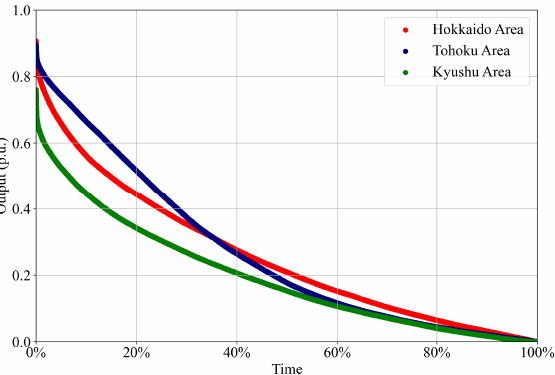
Figure 2. Duration curves of wind power output in the Hokkaido, Tohoku, and Kyushu areas in the 2012 fiscal year.